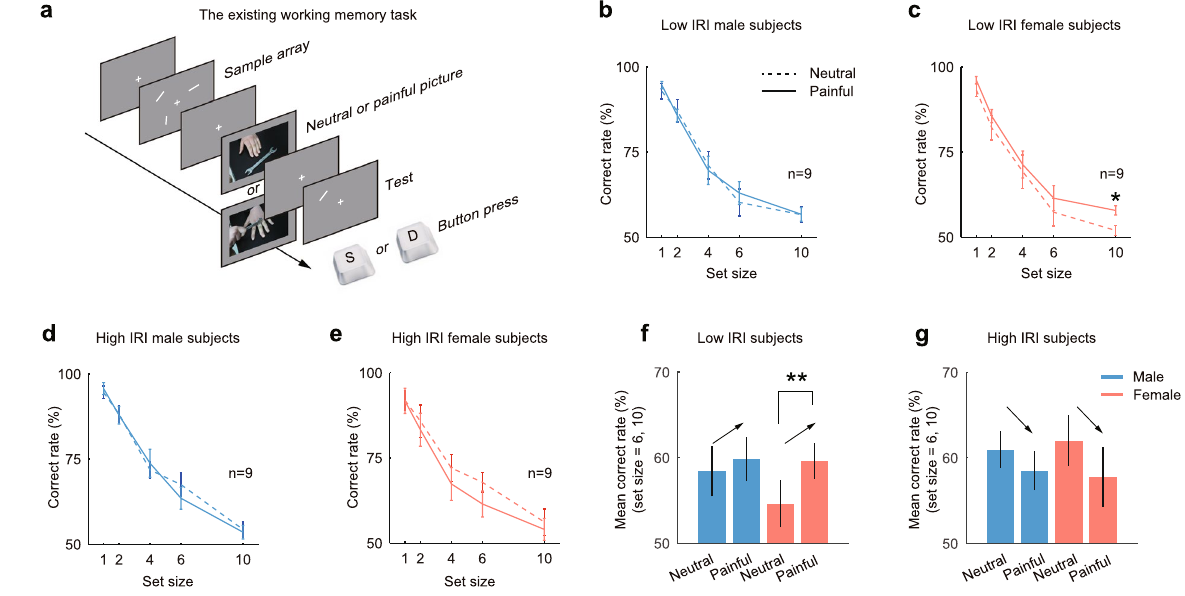
Figure 4. The influences of empathic pain on the existing working memory. (a) The existing working memory task tested influences of painful pictures on the working memory of events which occurred in the past, so painful or neutral pictures were presented after the sample array onset. The sample array still randomly consisted of 1, 2, 4, 6 or 10 bars. The working memory period was the time interval between sample array offset and test bar onset. (b,c) The performances of low IRI male subjects (b) and low IRI female subjects (c) . For the low IRI male subjects, there was no statistical difference between neutral (dashed line) and painful conditions (solid line). For the low IRI female subjects, the correct rates under the painful condition were higher than those under the neutral condition across all set sizes, and the difference was significant at set size 10 ( P = 0.0153, d.f. = 16, t -test, d = 1.2792). (d,e) The performances of high IRI male subjects (d) and high IRI female subjects (e) . Generally, the working memory at large set sizes (set size = 6, 10) was impaired for both genders. (f) In d.f. = 8, paired t -test, d = 0.6802). (g) For the high IRI subjects, the mean correct rates (set size = 6, 10)